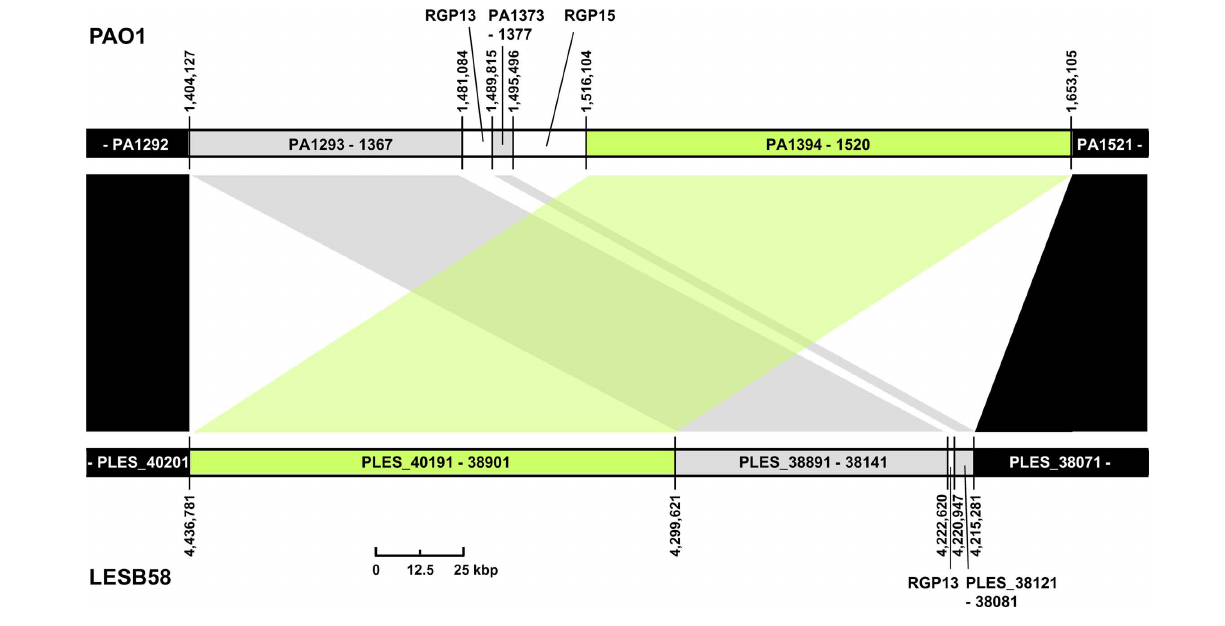
FIGURE 3 |Transposition of core genome DNA in LESB58. The genomic region with different core genome architecture is shown for strains PAO1 and LESB58. One hundred thirty-seven kbp of DNA (green) are located upstream of other core genome DNA blocks (gray) in LESB58 while occurring downstream of them in PAO1 (and other genomes). Surrounding core